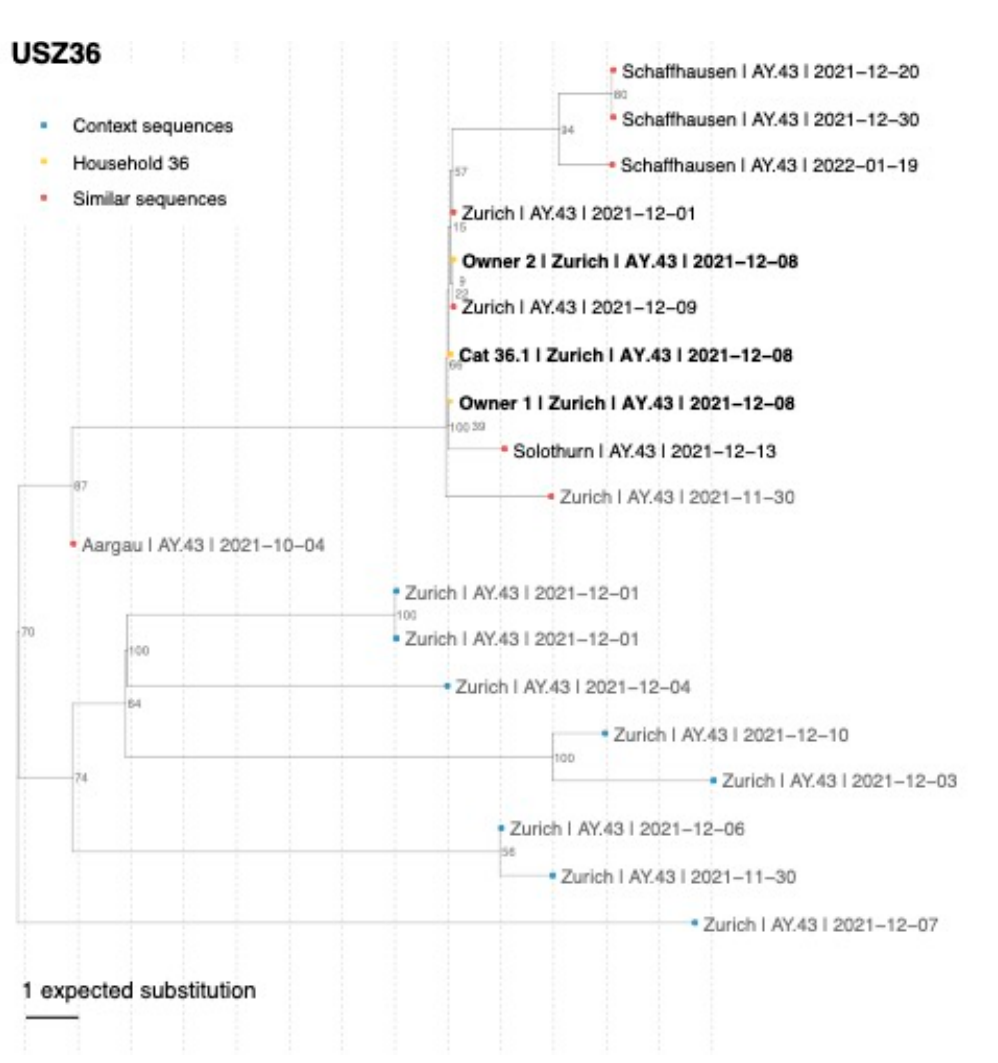
Figure A5. Maximum-likelihood phylogenetic tree showing the relationship between the three sequences of USZ36 (yellow dots and bold text) and their respective 10 most genetically similar Swiss sequences from GISAID. The most similar sequences (red dots) are defined as those with the smaller number of SNPs differences to each household sequence (sequences that are part of the 10 closest sequences for several of the household sequences only appear once in the tree). Blue dots indicate a representative set of 10 sequences circulating in Zurich in December 2021 from pangolin lineage AY.43 (context sequences). Location, pangolin lineage, and collection date are shown for each sequence. Bootstrap values for the internal nodes are shown next to each node from 10,000 bootstrap replicates.